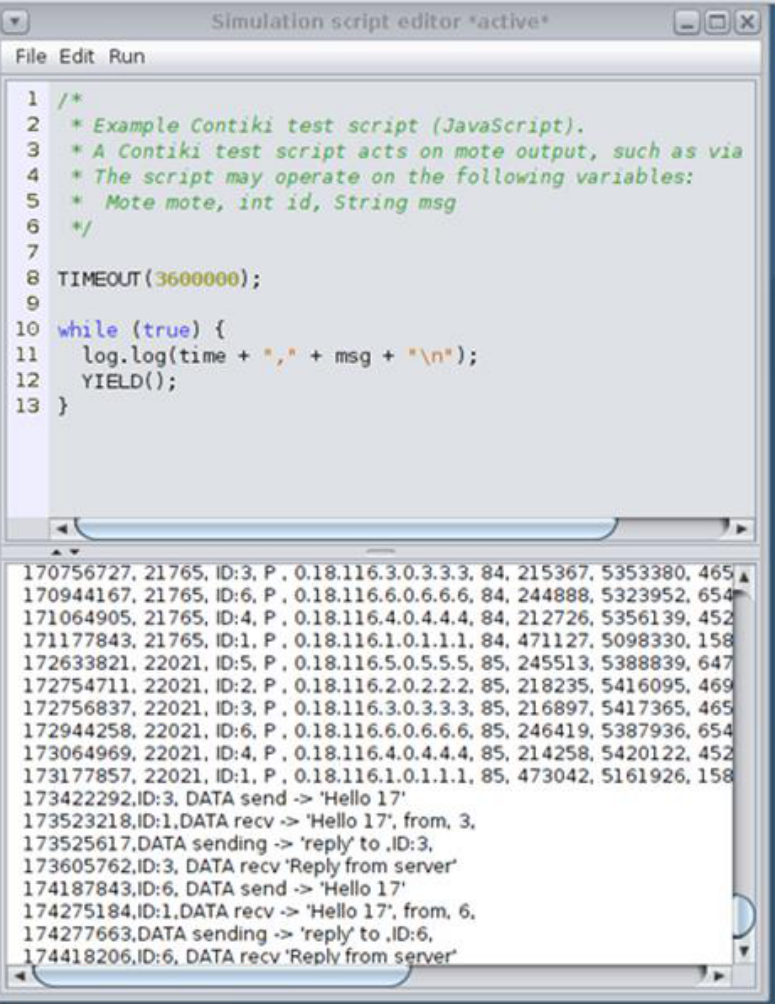
Figure 7. Simulation script editor.